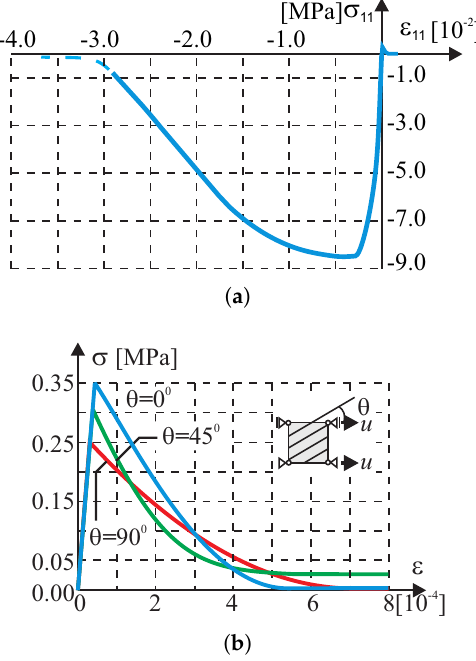
Figure 8. Single-element test results. Relationship σ − ε : ( a ) compression along 1(x) axis, ( b ) tensile softening in the direction rotated by an angle θ to the first orthotropy